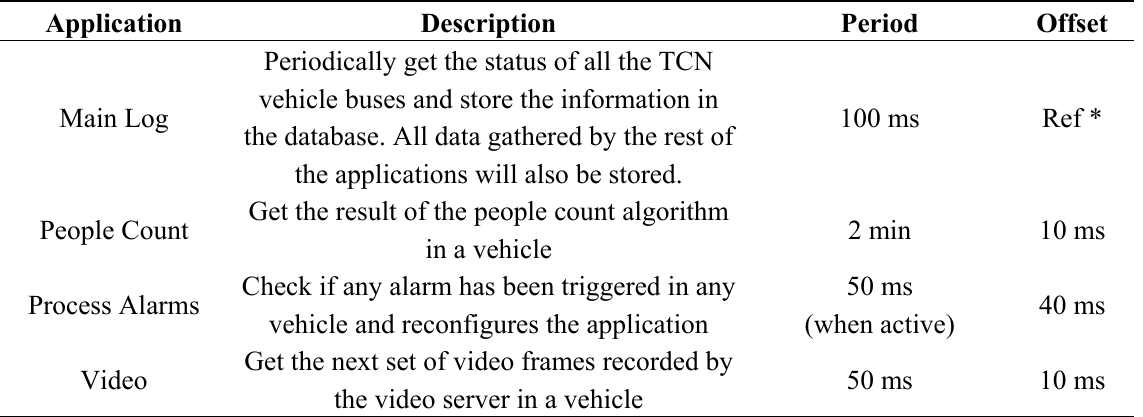
Table 1. Description of the FTT applications of the TCN use case.